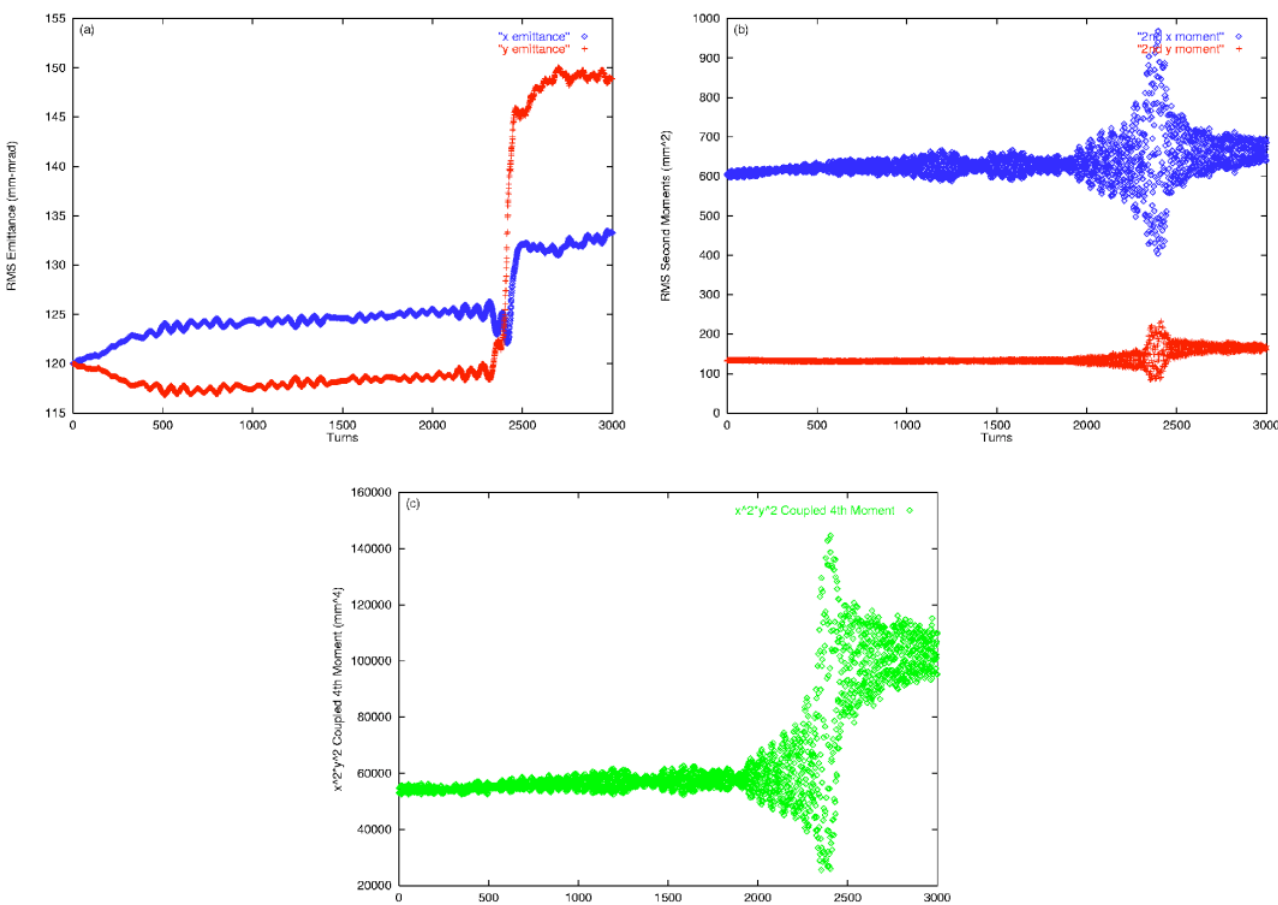
FIG. 15. (Color) Evolution of (a) rms emittances, (b) second moments (cid:6) D x 2 (cid:7) and (cid:6) D y 2 (cid:7) , and (c) fourth moments (cid:6) D x 2 D y 2 (cid:7) for n x (cid:1) n y (cid:1) 5.82 . Although not plotted here, (cid:6) D x 4 (cid:7) and (cid:6) D y 4 (cid:7) are similar to (cid:6) D x 2 D y 2 (cid:7) in